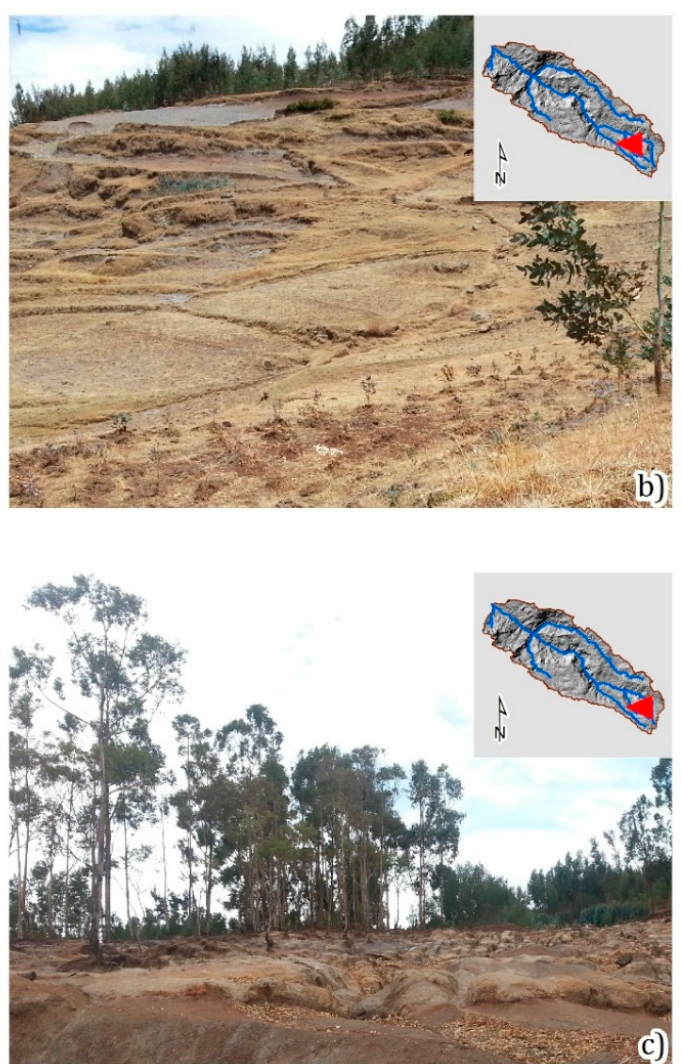
Figure 2. Examples of mapped erosional landforms: ( a ) Gully erosion; ( b ) Sheet erosion; ( c ) Badland